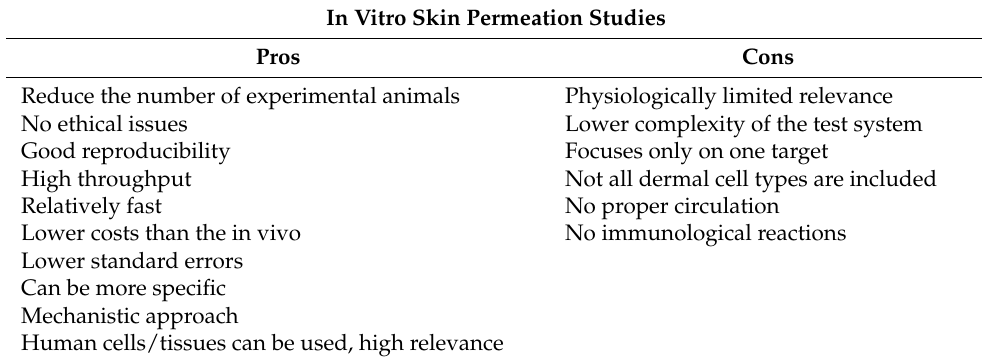
Table 7. Advantages and limitations of the use of in vitro skin assays contrary to the in vivo models. In Vitro Skin Permeation Studies Pros Cons Reduce the number of experimental animals Physiologically limited relevance No ethical issues Lower complexity of the test system Focuses only on one target Not all dermal cell types are included No immunological